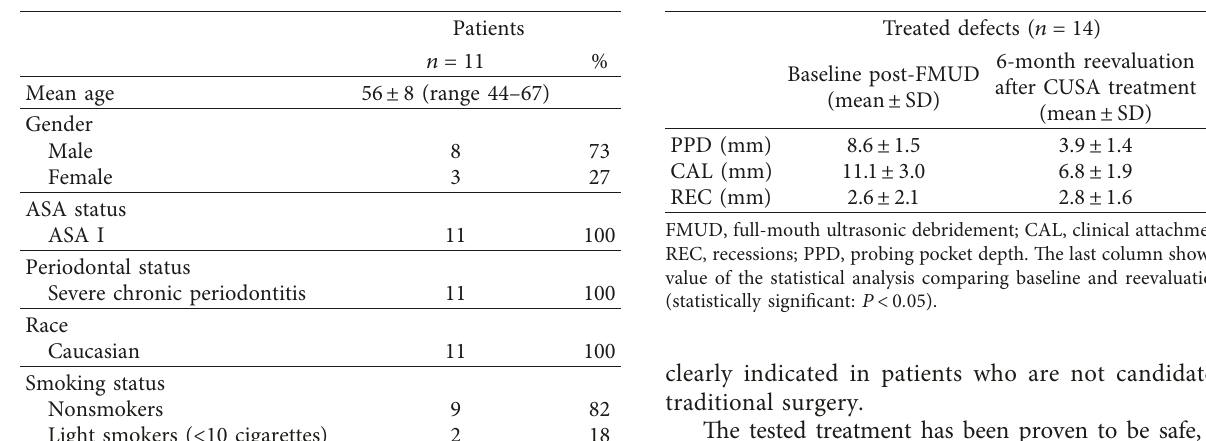
Figure 5: This sequence shows an infrasulcular approach to fragment the tissue. The sonotrode was inserted in a periodontal pocket (a). The tip of the device, placed in contact with the tissues, destroys and emulsifies cells that are irrigated and removed through a built-in suction tube (b). After CUSA treatment, a blood clot fills the target area (c, d). Table 1: Demographic and clinical baseline variables. Table 2: Clinical variables before and after CUSA